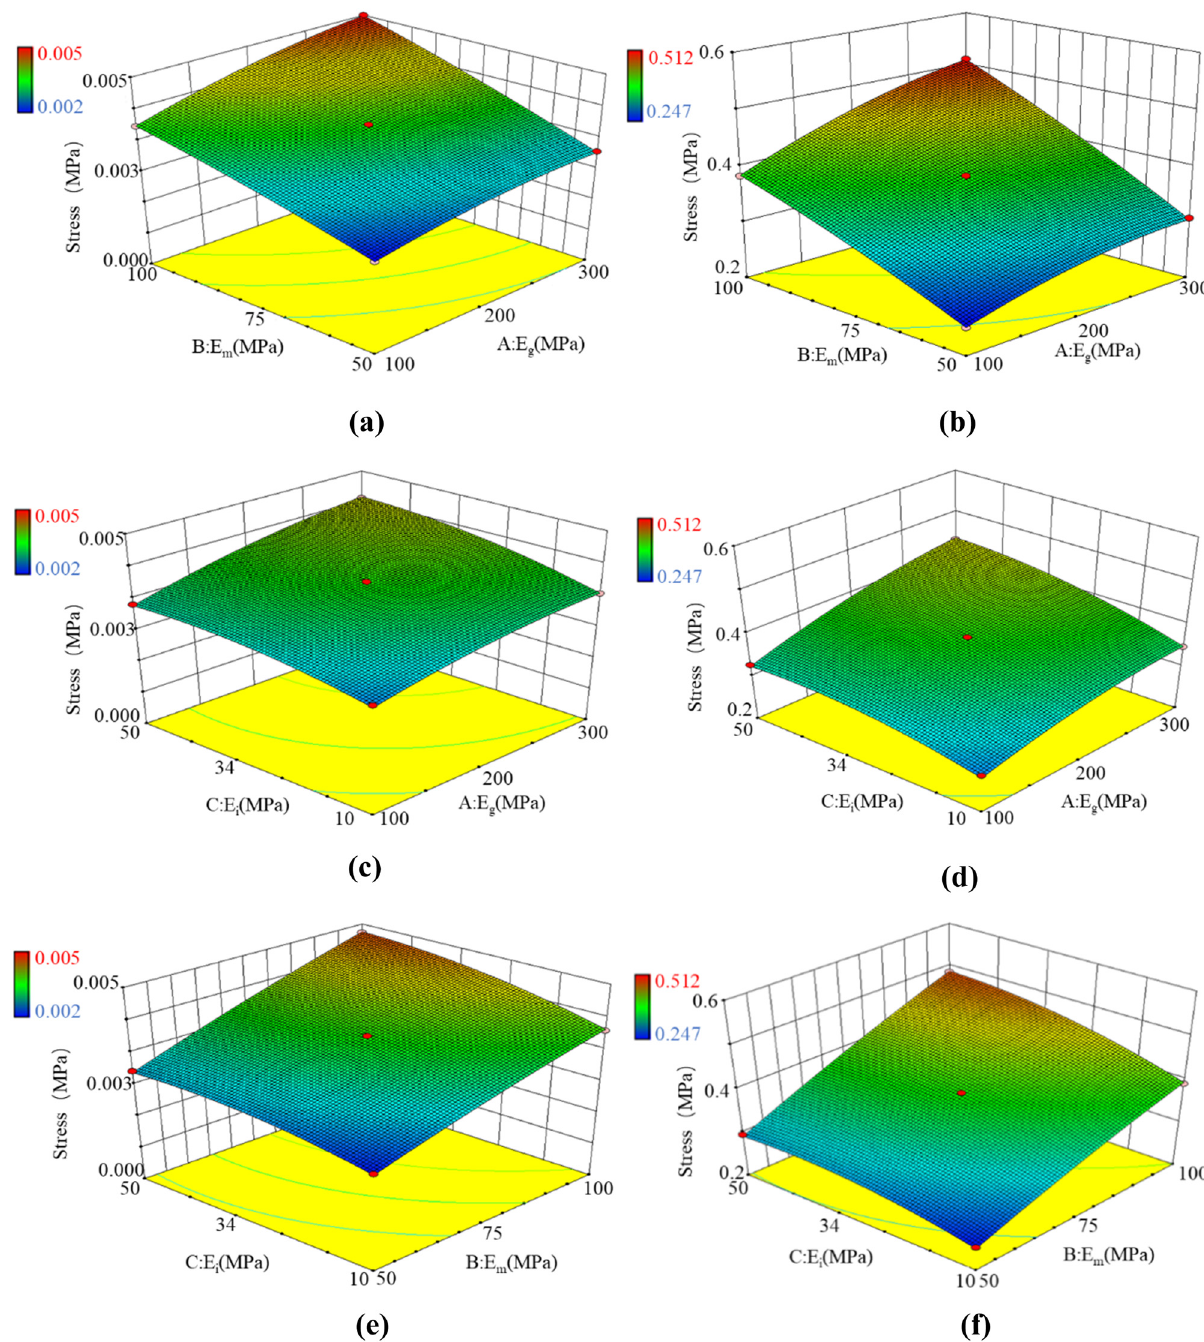
Figure 4: Comparative analysis of the in fl uence of interaction terms on σ σ and 1 2 . ( a ) The in fl uence of AB interaction term on σ 1 . ( b )